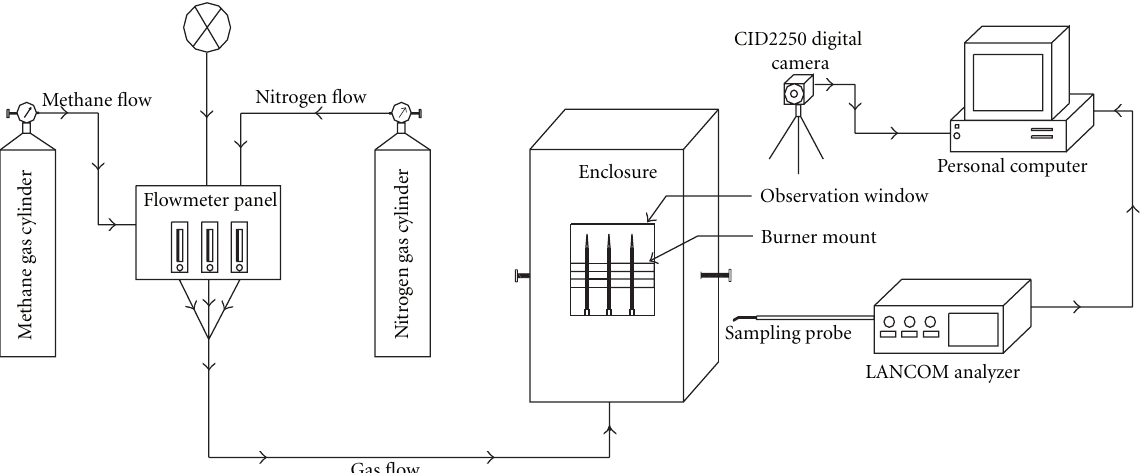
Figure 10: Experimental apparatus.